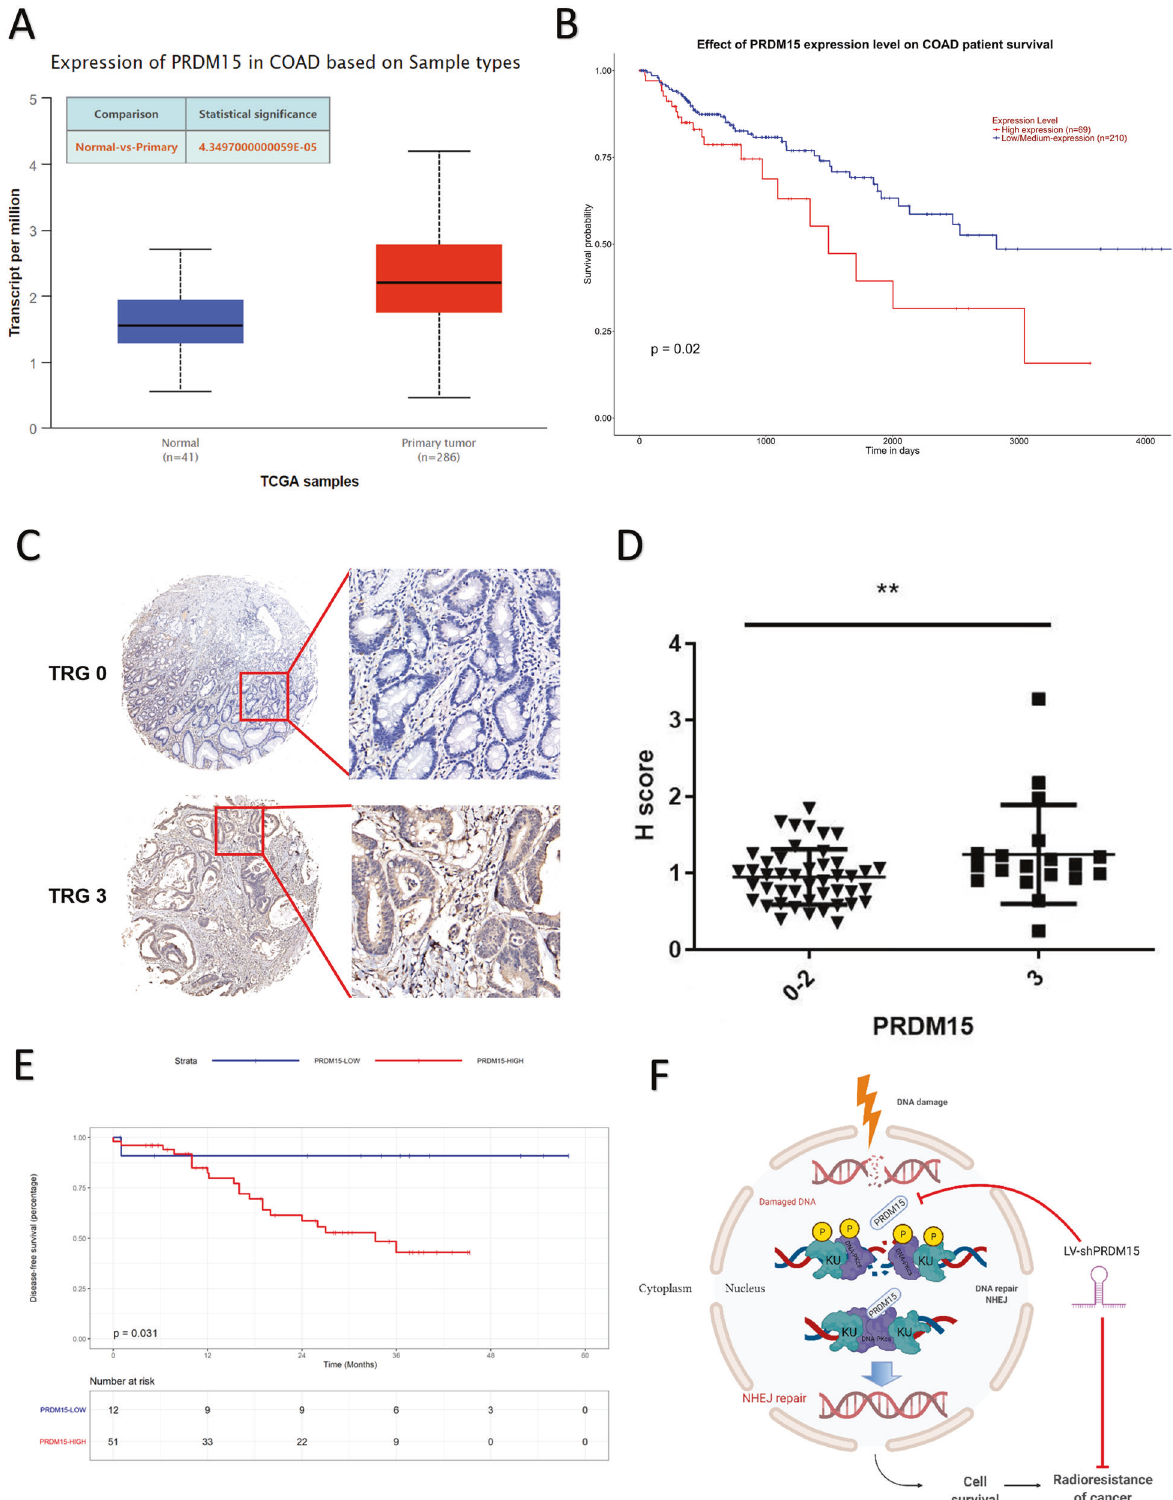
Fig. 8 PRDM15 promotes radioresistance and poor prognosis in clinical patients. A The expression of PRDM15 in colon adenocarcinoma (COAD) ( n = 41 for normal tissue, n = 286 for colorectal adenocarcinoma tissue, p < 0.05) in TCGA datasets. B Effect of PRDM15 expression level on colorectal adenocarcinoma patients survival. ( n = 69 for high expression, n = 210 for low/medium-expression). C Tissue microarray results of PRDM15 expression in clinical rectal cancer. TRG: tumor regression grade. TRG = 0 indicates complete tumor regression; TRG = 3 indicates the worst tumor regression. D Immunohistochemical staining H score of PRDM15 in rectal cancer tissues. Cancer tissues from TRG3 group was considerably higher than that from TRG0-2 group. Values are given as mean ± SD, two tailed Student ’ s t test. ** P < 0.01. E Kaplan – Meier survival analysis of clinical patients from the microarray. (F) Schematic diagram of how the PRDM15 regulates NHEJ repair and radiosensitivity.